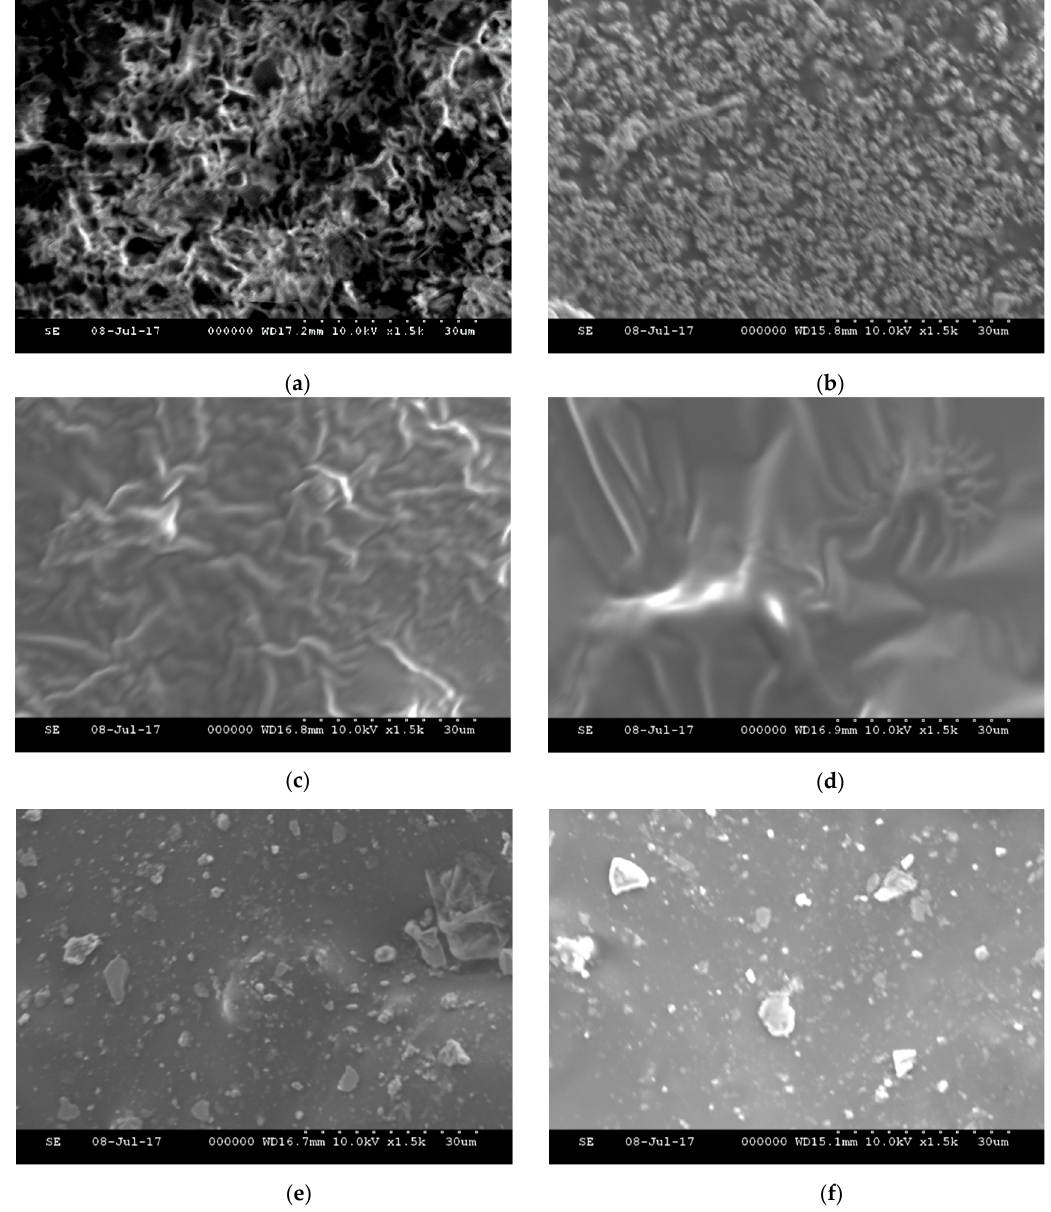
Figure 11. Micrographs of the weak rock before and after curing at different polymer–cement ratios: ( a ) P/C = 0; ( b ) P/C = 0.5; ( c ) P/C = 1.0; ( d ) P/C = 1.5; ( e ) P/C = 2.0; ( f ) P/C = 2.5.